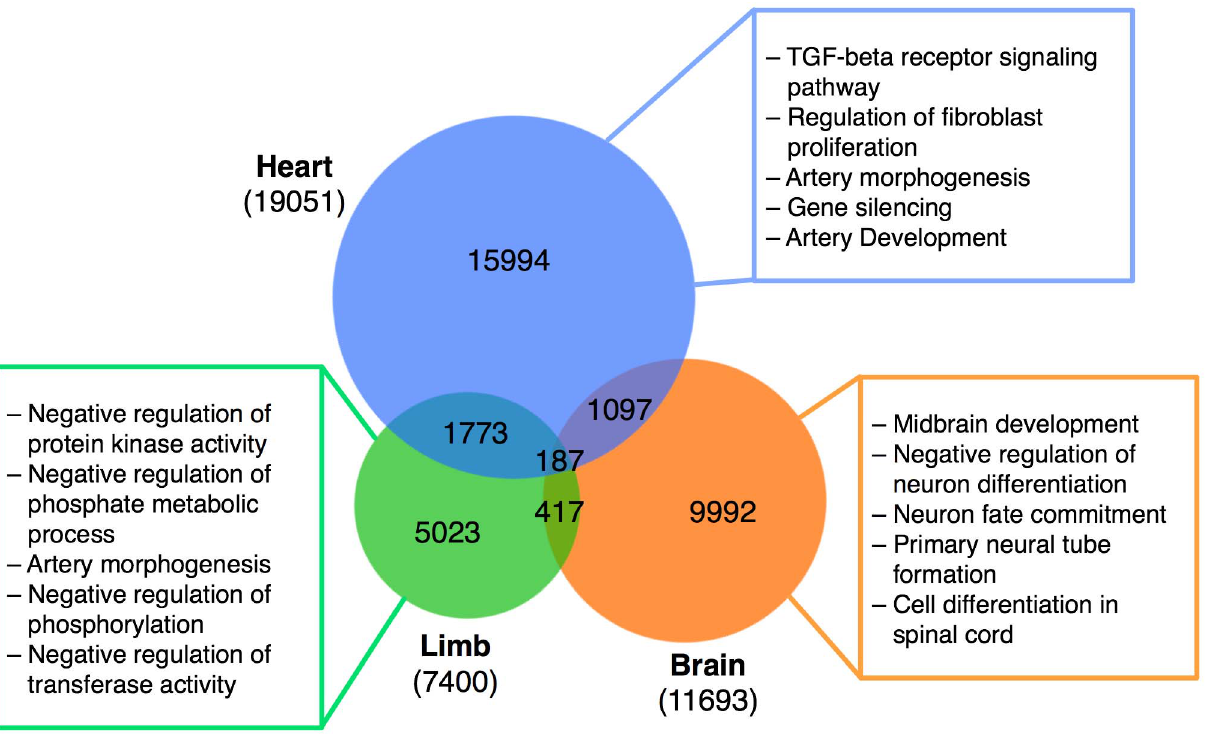
Figure 6. Predicted tissue-specific enhancers exhibit tissue-specific characteristics. EnhancerFinder identifies thousands of novel high- confidence (FPR , 0.05) heart, brain, and limb enhancers. These enhancers are enriched for tissue-specific GO Biological Processes. The five most enriched GO Biological Processes among genes near each enhancer set (as calculated using GREAT) are listed in the colored boxes. Nearly 90% of EnhancerFinder predicted heart, brain, and limb enhancers are unique to a single tissue. The larger number of high-confidence heart enhancers relative to brain and limb enhancers is the result of the superior performance of the heart classifier.